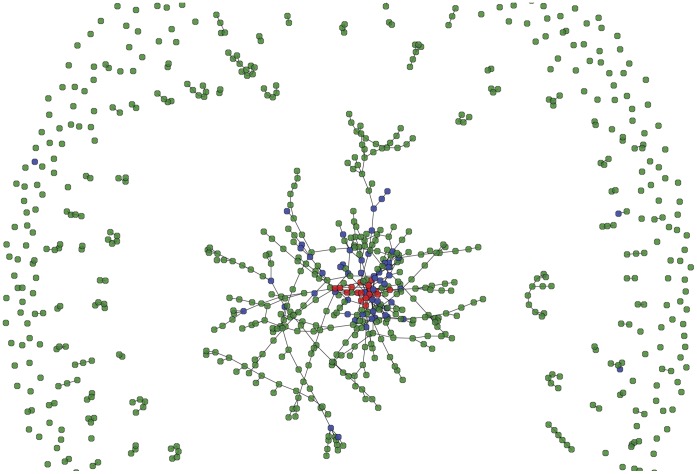
Risk network structure at model initialization of a representative subsample of 1000 agents, stratified by drug use status (IDUs, NIDUs, and NUs are represented by red, blue, and green nodes, respectively).Links indicate sexual activity and/or (if a pair of IDU) injecting event(s) between two agents. In the figures shown above, the average node degree is 1.198.